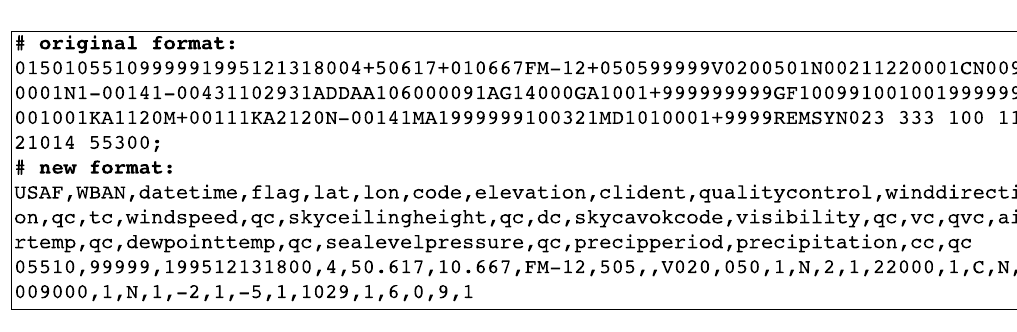
Figure 2. Original and new CSV (with shortened header information) text file format for a single meteorological